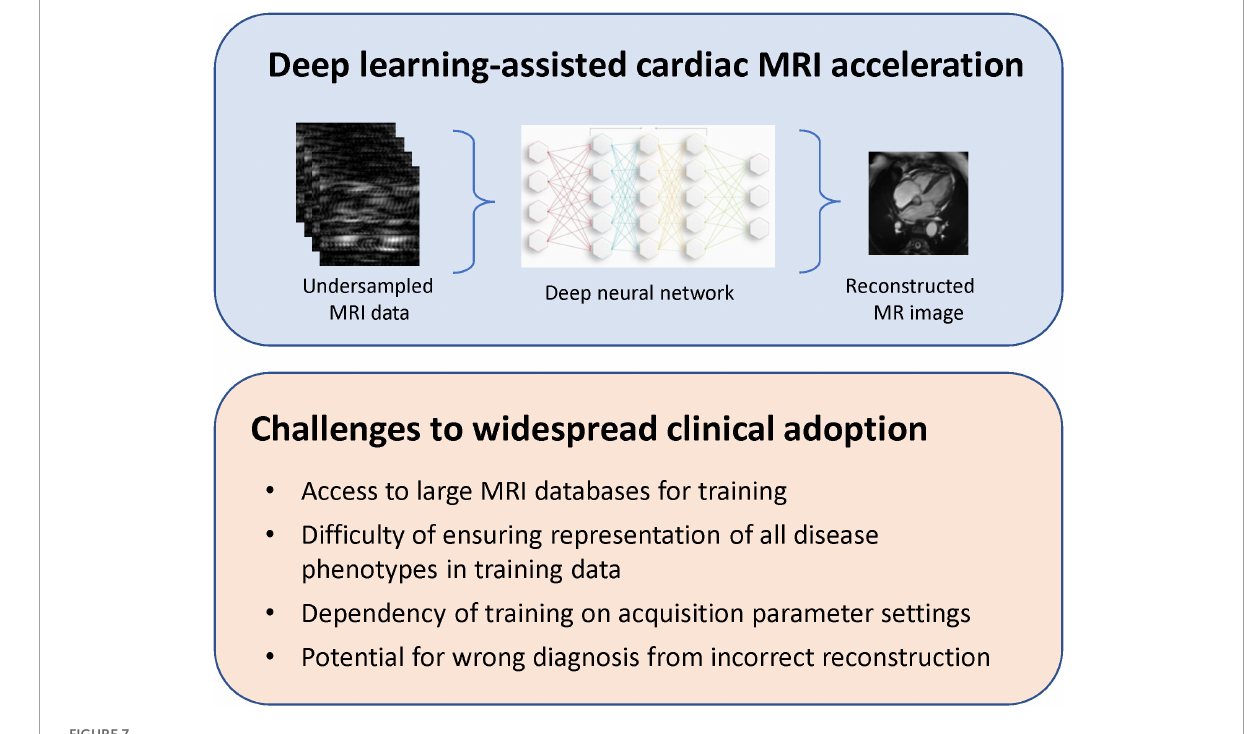
FIGURE7 Deep learning-assisted cardiac MRI acceleration. Despite having demonstrated an ability to reconstruct high-quality cardiac MRI from undersampled k-space datasets, deep learning-assisted MRI acceleration face important challenges that must be addressed to ensure flexible, reliable, and widespread